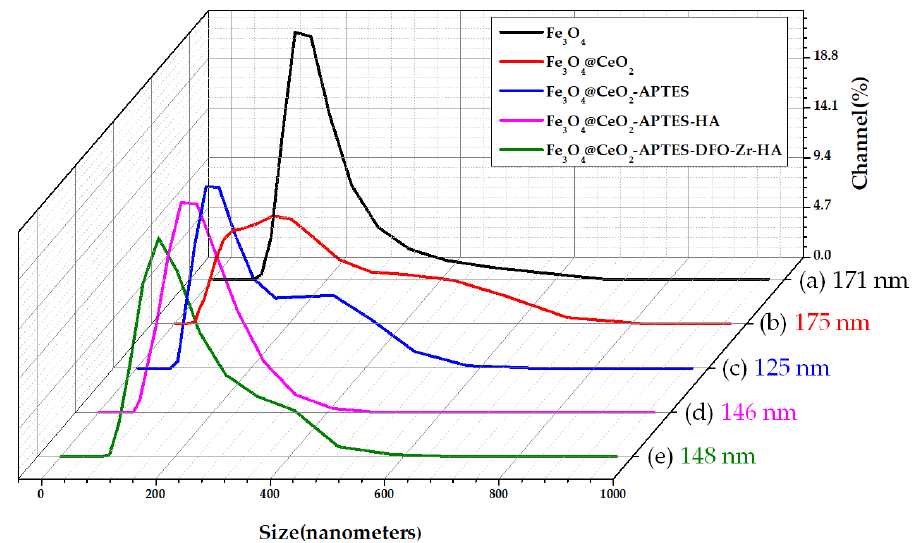
Figure 6. DLS analysis graph for the average particle size determination of: ( a ) Fe 3 O 4 , ( b ) Fe 3 O 4 @CeO 2 , ( c ) Fe 3 O 4 @CeO 2 -APTES, ( d ) Fe 3 O 4 @CeO 2 -APTES-HA and ( e ) Fe 3 O 4 @CeO 2 -APTES-DFO-Zr-HA in dispersed forms.